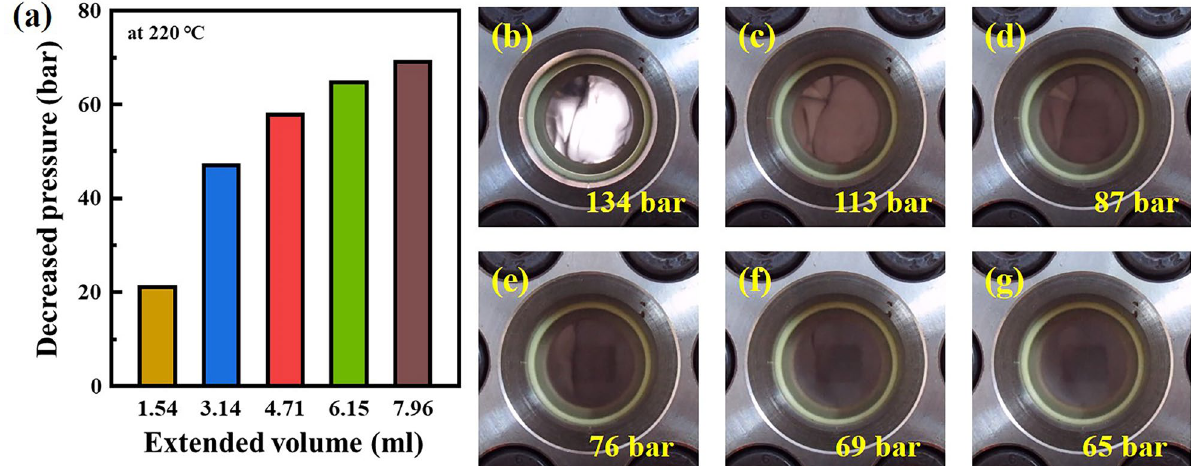
Figure 2. Dropped pressure against the extended volume of the HDPE/SCF solution and the optic images of phase changes at each reduced pressure. ( a ) Pressure–volume relationship and phases at: ( b ) 134 bar, ( c ) 113 bar, ( d ) 87 bar, ( e ) 76 bar, ( f ) 69 bar, and ( e ) 65 bar (the initial pressure: 134